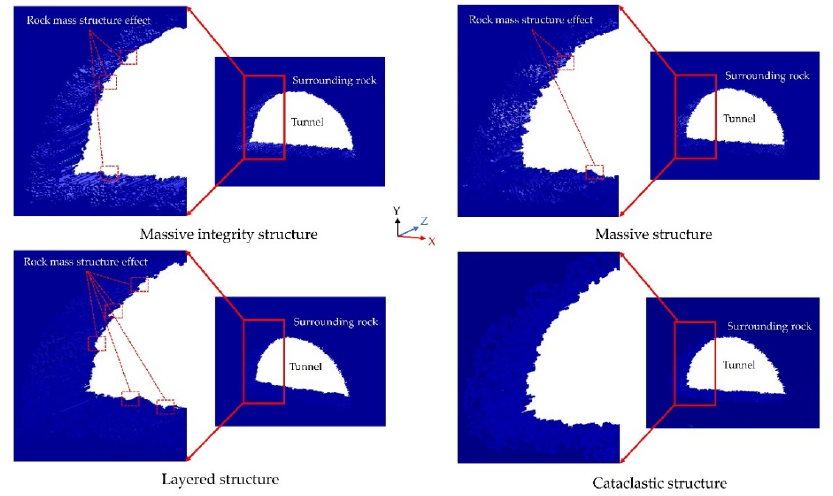
Figure 9. Tunnel contours with different rock mass structures.